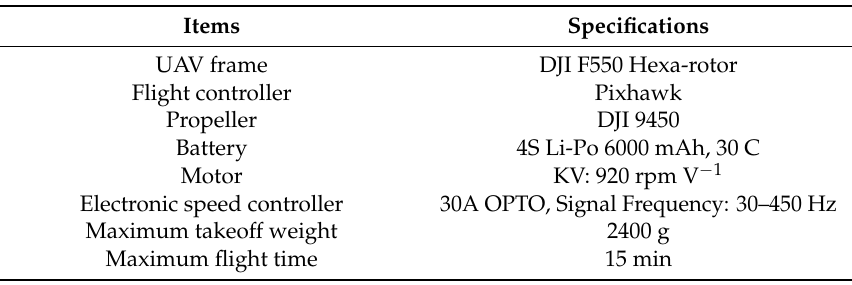
Table 1. Specifications of the unmanned aerial vehicle (UAV)